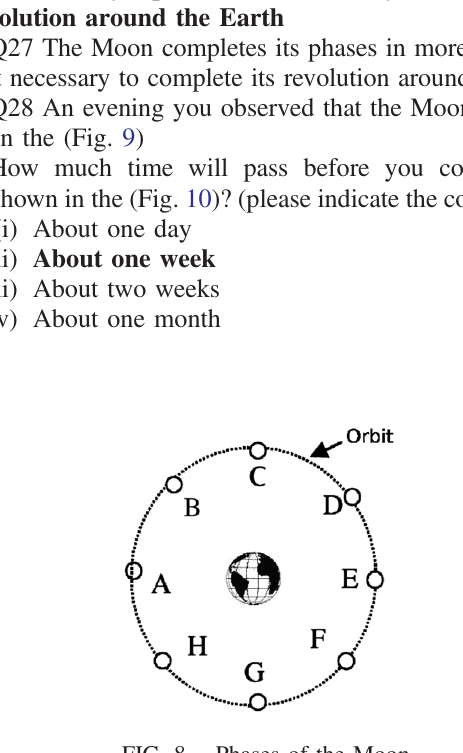
FIG. 8. Phases of the